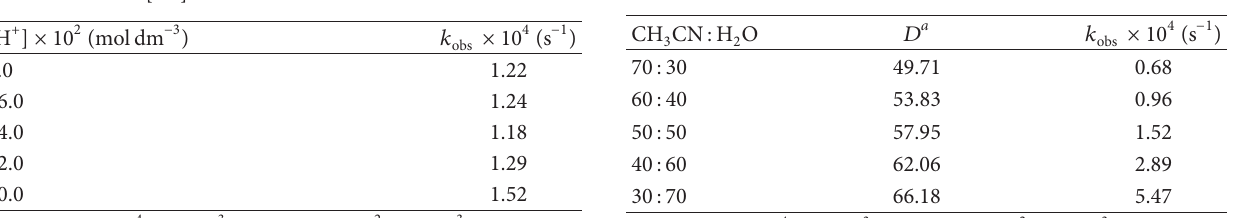
T 4: Effect of dielectric constant on the reaction rate at